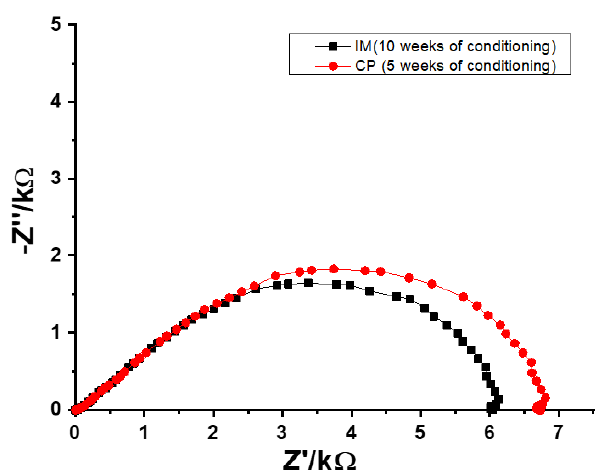
Figure 3. Typical impedance spectra of CP SSC and IM SSC reference electrodes recorded after 5 and 10 weeks of conditioning,